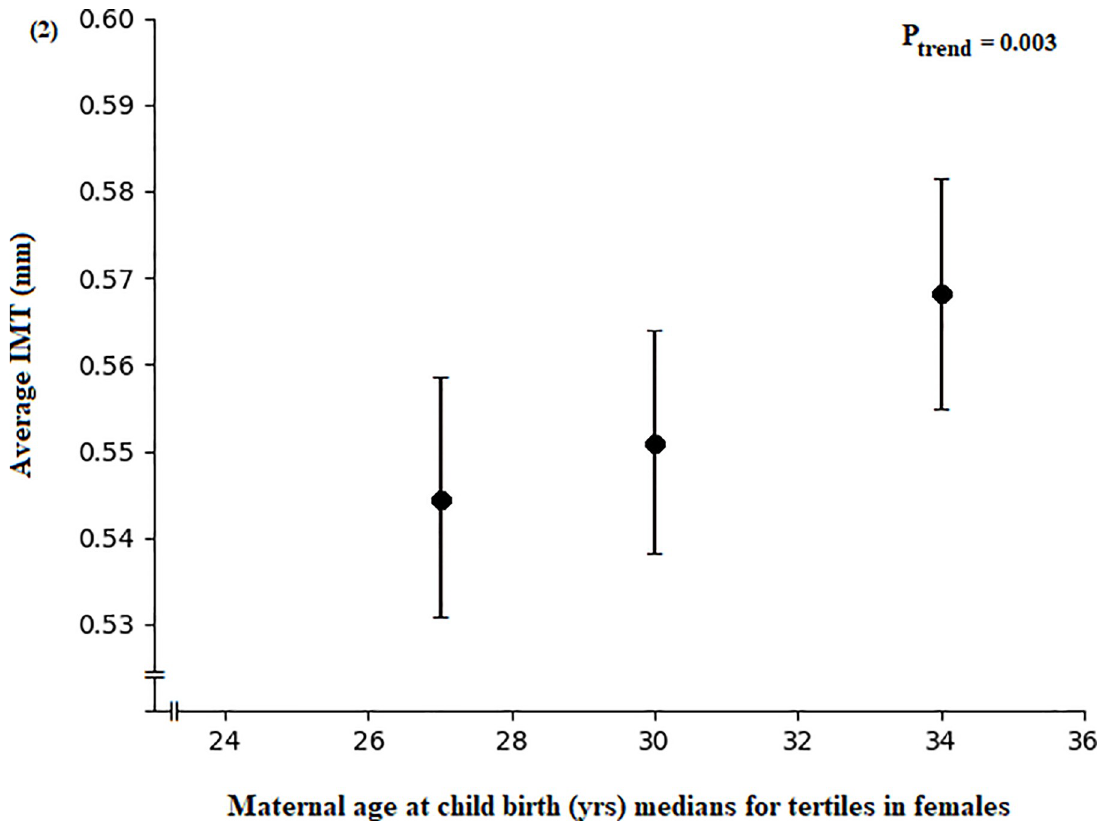
Fig 2. Association between maternal age at child birth and intima media thickness. Maternal age at child birth by tertiles of average IMT adjusted for age by the residual method in young adulthood among female participants. Data are means and 95% CI adjusted for adult age at IMT measurement, the physician taking the IMT measurement and birth year (residuals of birth year were calculated on age at IMT measurement), (n =